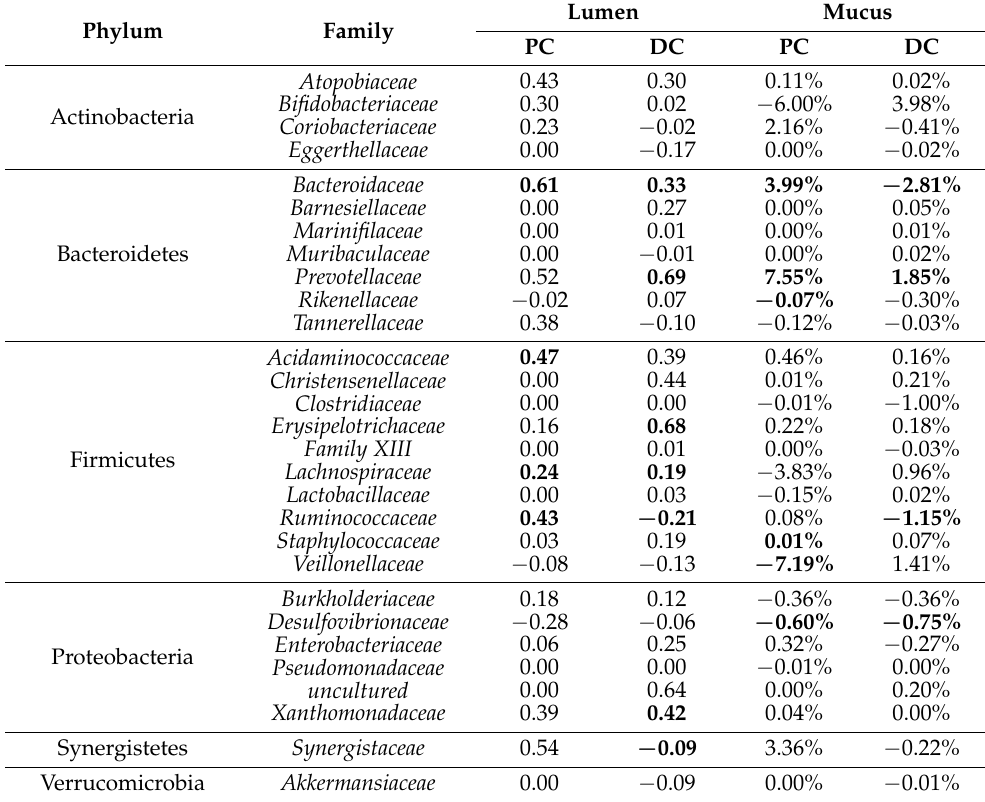
Table 1. Effect of cRG-I on microbial composition at family level in the lumen (log cells/mL as estimated via multiplying total cell counts (cells/mL) with 16S rRNA gene profiling (%)) and mucus (%) of the simulated proximal (PC) and distal colon (DC) of the quad-M-SHIME. Values presented are the averages of the differences at the end of the treatment period (Day 35) versus those at the end of the control period (Day 14) across the four human adult donors tested ( n = 4). As a result, positive or negative values indicate families that are increased or decreased, respectively, upon cRG-I treatment. Statistical differences are indicated in bold.